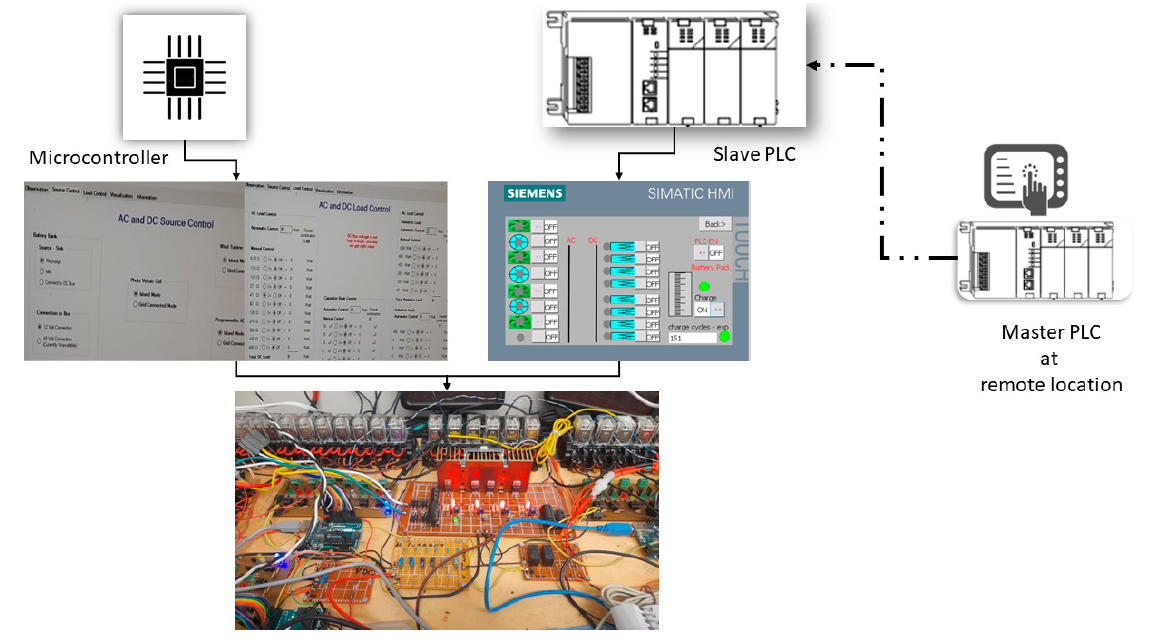
Figure 4. The resilient design of the